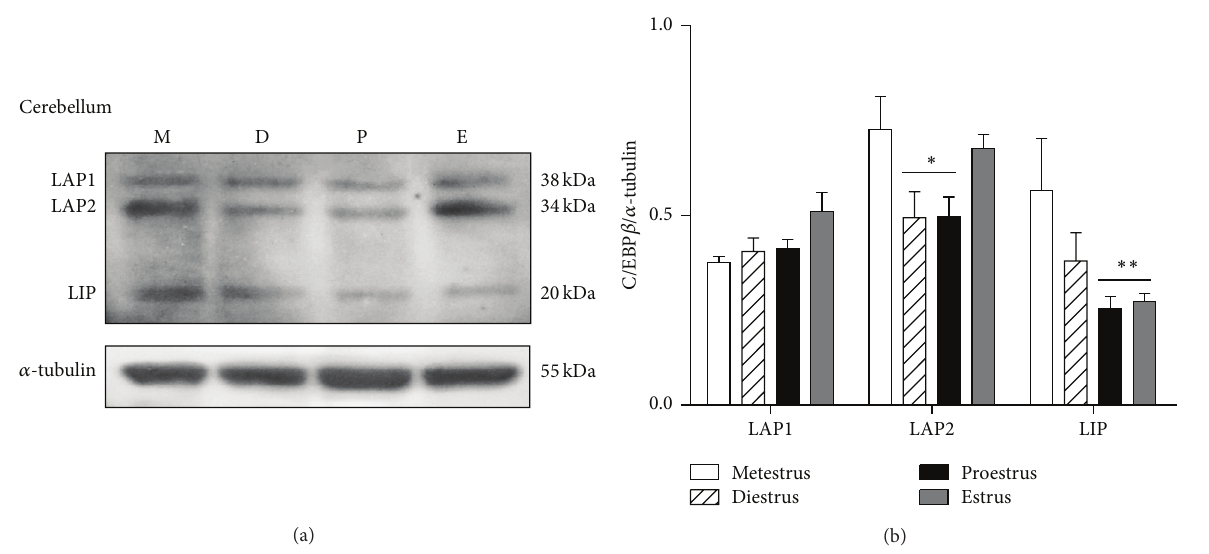
Figure 1: C/EBP 𝛽 isoforms LAP1, LAP2, and LIP content in the rat cerebellum throughout the estrous cycle. (a) A representative western blot for the three C/EBP 𝛽 isoforms during metestrus (M), diestrus (D), proestrus (P), and estrus (E). (b) Densitometric analysis of C/EBP 𝛽 isoforms with respect to 𝛼 -tubulin content. The data represent the mean ± S.E.M, 𝑛 = 6 , ∗ 𝑃 < 0.05 LAP2 diestrus and proestrus versus metestrus and estrus; ∗∗ 𝑃 < 0.05 LIP proestrus and estrus versus metestrus and diestrus.